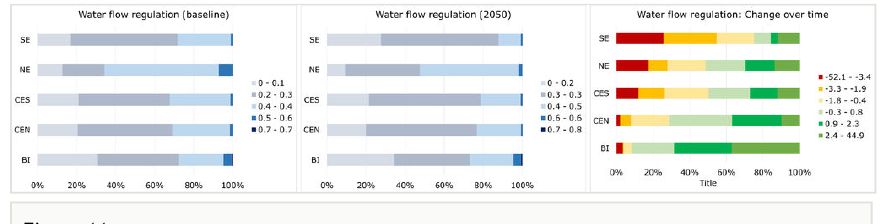
Figure 11. From left to right, water fl ow regulation for the baseline, the 2050 and as percent change over time. The scores are shown in relation to the percent extent of fi ve European regions, de fi ned after grouping the 28 Member States (MS) according to their climatic characteristics (Ciscar Martinez et al. 2011). The chart on the right shows the percent change over time in the predicted air quality regulation, for the same set of regions. In all charts, the y-axis shows the di ff erent regions (SE: South Europe; CEN: Central Europe North; CES: Central Europe South; NE: North Europe; BI: British Isles). See Suppl. material 3 for a grouping of MS within each region. See main text for additional